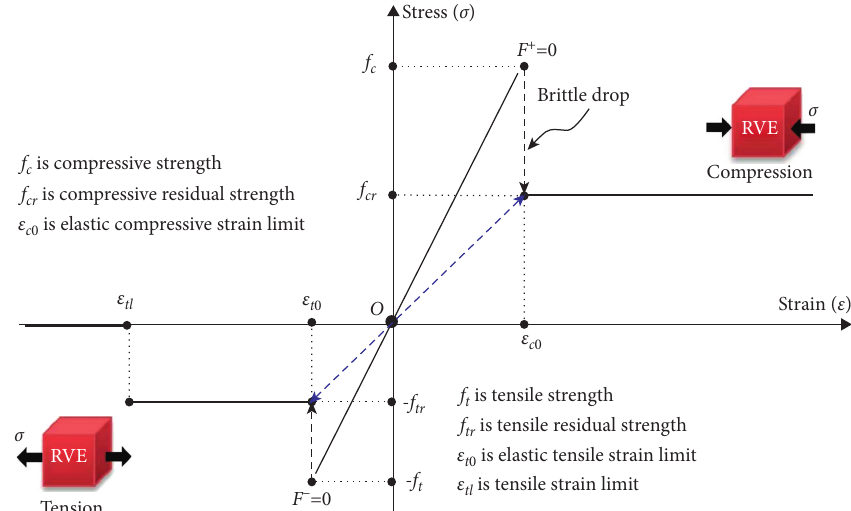
Figure 2: Constitutive relationship of mesoscale damage of